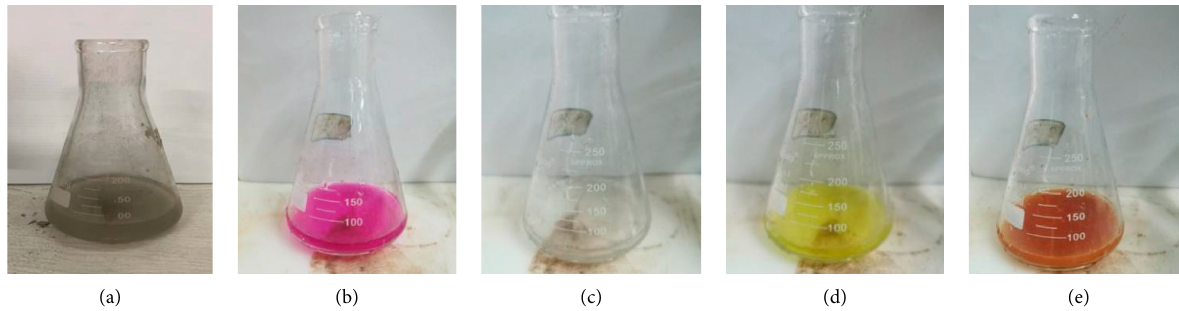
Figure 6: (a) Distilled water to dissolve samples. (b) Dropoing phenolphthalein. (c) Diluting sulphuric acid neutralized to colourless. (d) Addition of potassium chromate. (e) Titration with AgNO 3 .